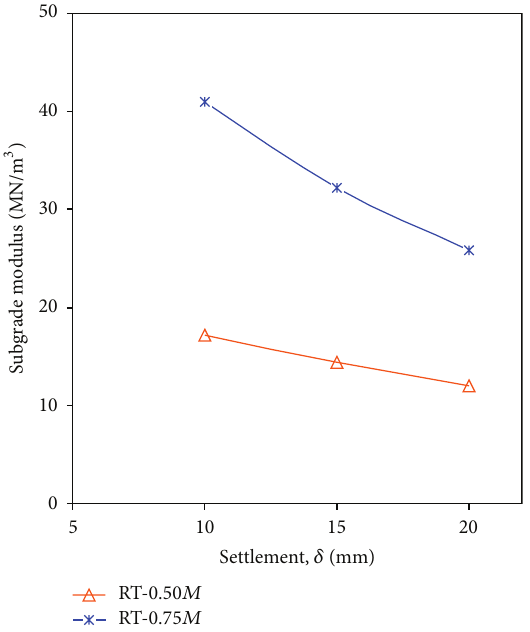
Figure 8: Subgrade modulus for reference tests, comparison.